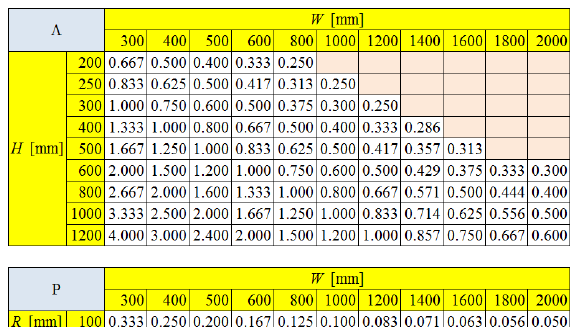
Fig. 1 Determination of dimensionless parameters.